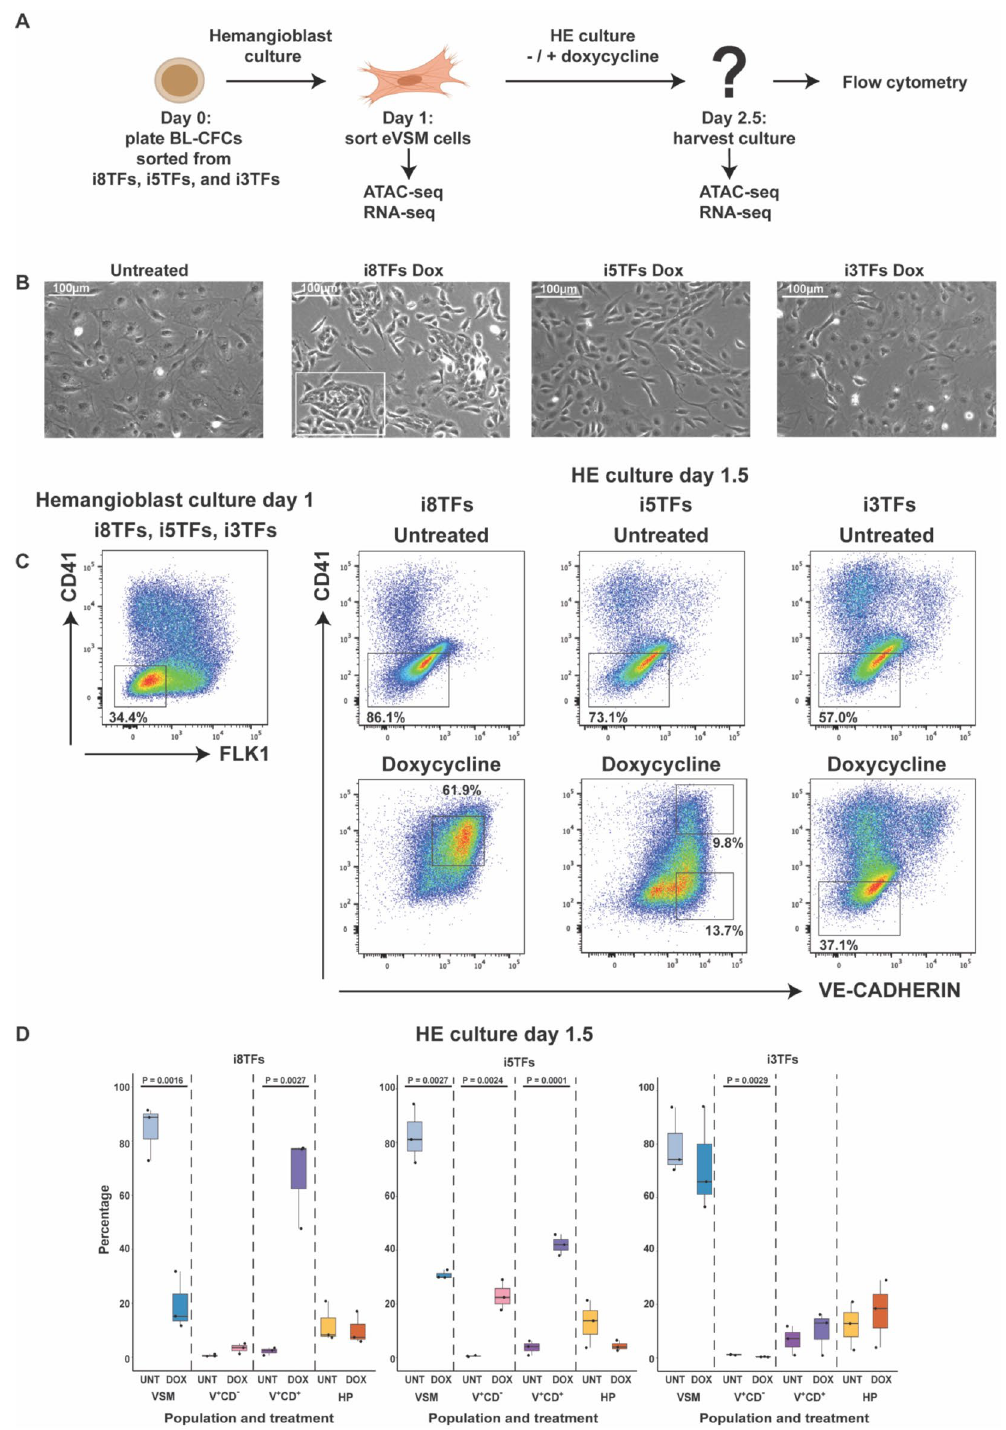
Figure 2. The simultaneous overexpression of the 5TFs transdifferentiates sorted eVSM cells into VE-CAD + CD41 + cells less efficiently compared to the 8TFs. ( A ) Experimental layout of the work. ( B ) Representative microscopy images of the indicated conditions at day 2.5 HE culture. VSM cells appear as large wide-spread cells; V + CD − cells appear as elongated cells; HPs appear as round floating cells. The white box highlights an example of the endothelial cell cluster from which hematopoietic cells normally arise. ( C ) Flow cytometry analyses of the indicated conditions. The squares highlight the populations sorted for cell culture and molecular biology. ( D ) Box plots showing the relative frequencies of VSM, V + CD − , V + CD + , and HP populations in HE culture from i8TFs, i5TFs and i3TFs lines (n = 3). Significance was determined by Analysis of Variance (ANOVA) test. Error bars correspond to standard